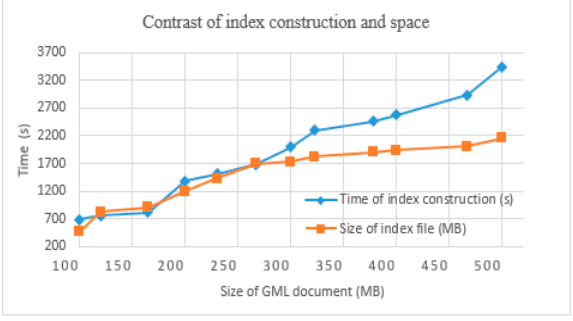
Figure 9. Time of index construction vs. space.